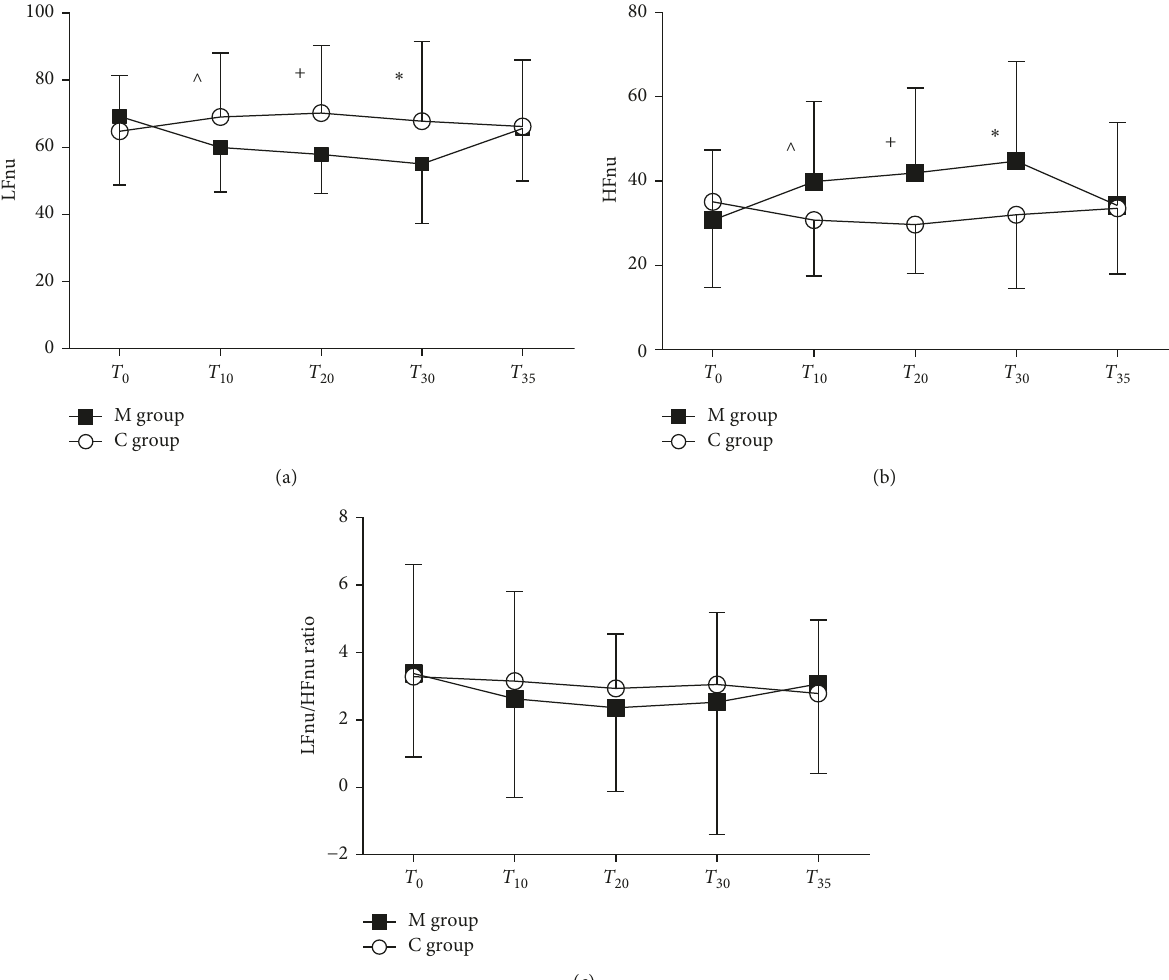
SD. ^ p 0 . 042, + p 0 . 007, and (cid:31) (cid:31) ±